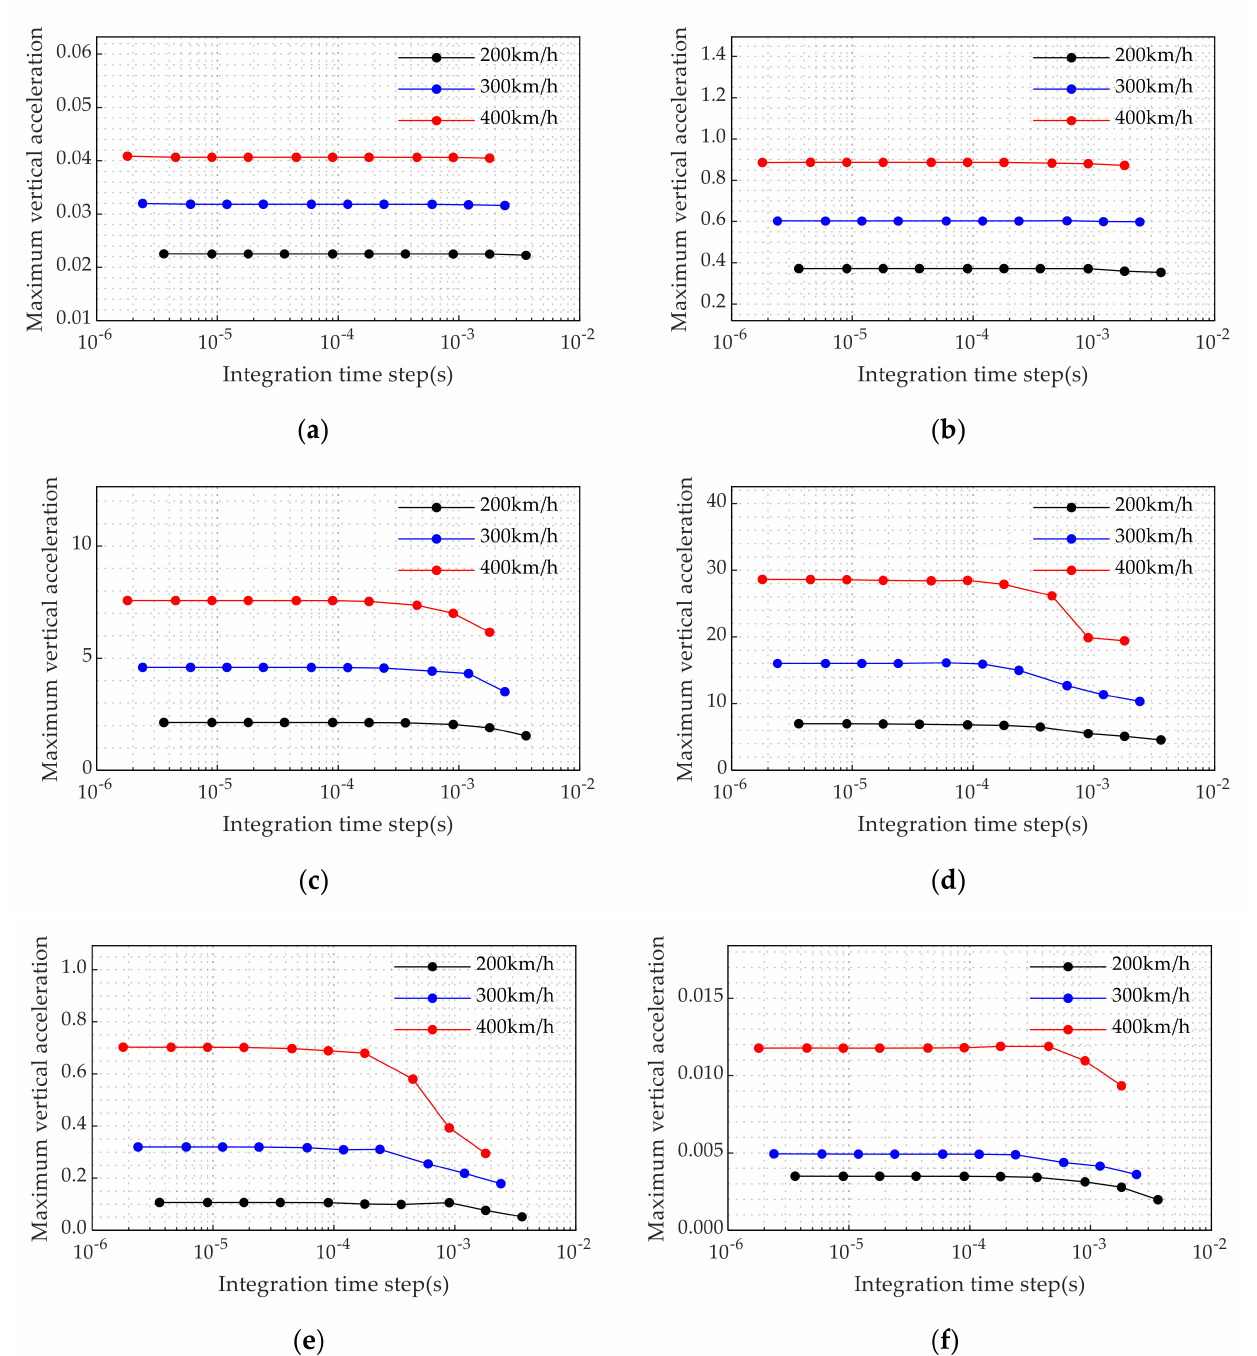
Figure 10. The effect of the integration time step on the maximum vertical acceleration of the: ( a ) car body; ( b ) bogie; ( c ) wheel-sets; ( d ) rail; ( e ) track slab; ( f ) bridge at different